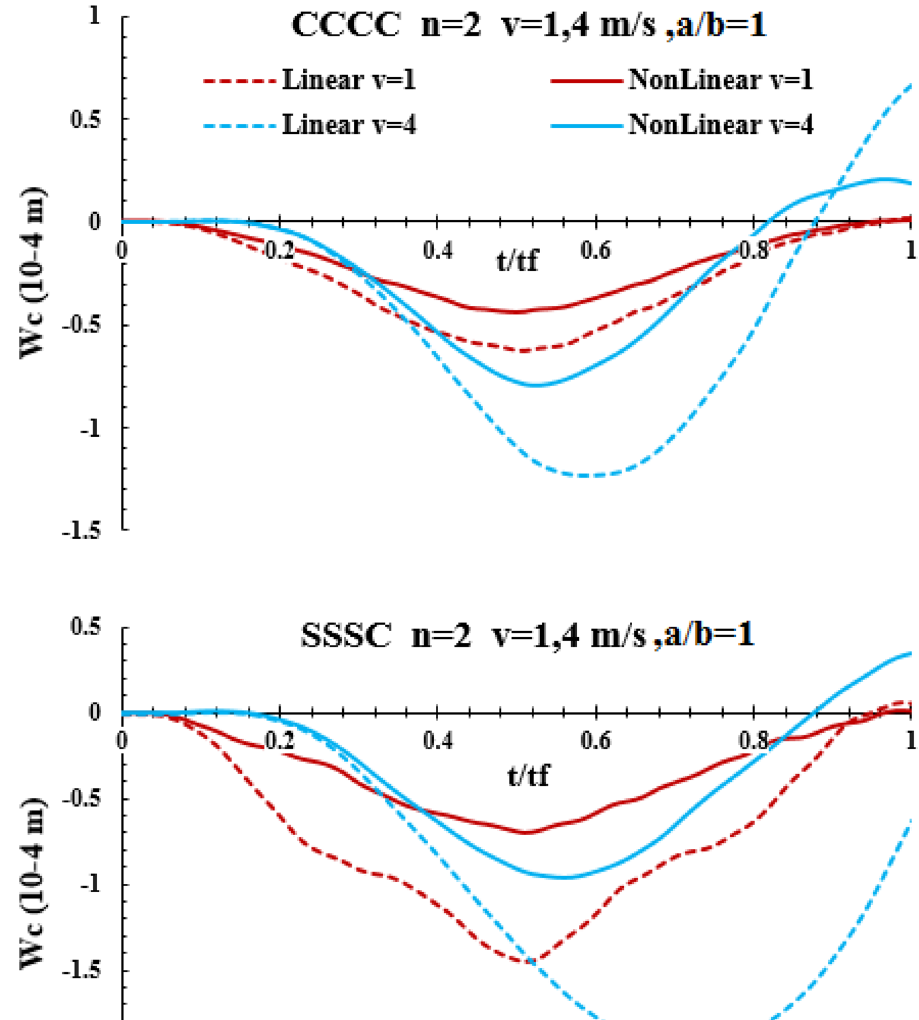
Fig. 9 The effect of velocity of moving force on deflection history of center-point of the plate (CCCC boundary condi- tion)